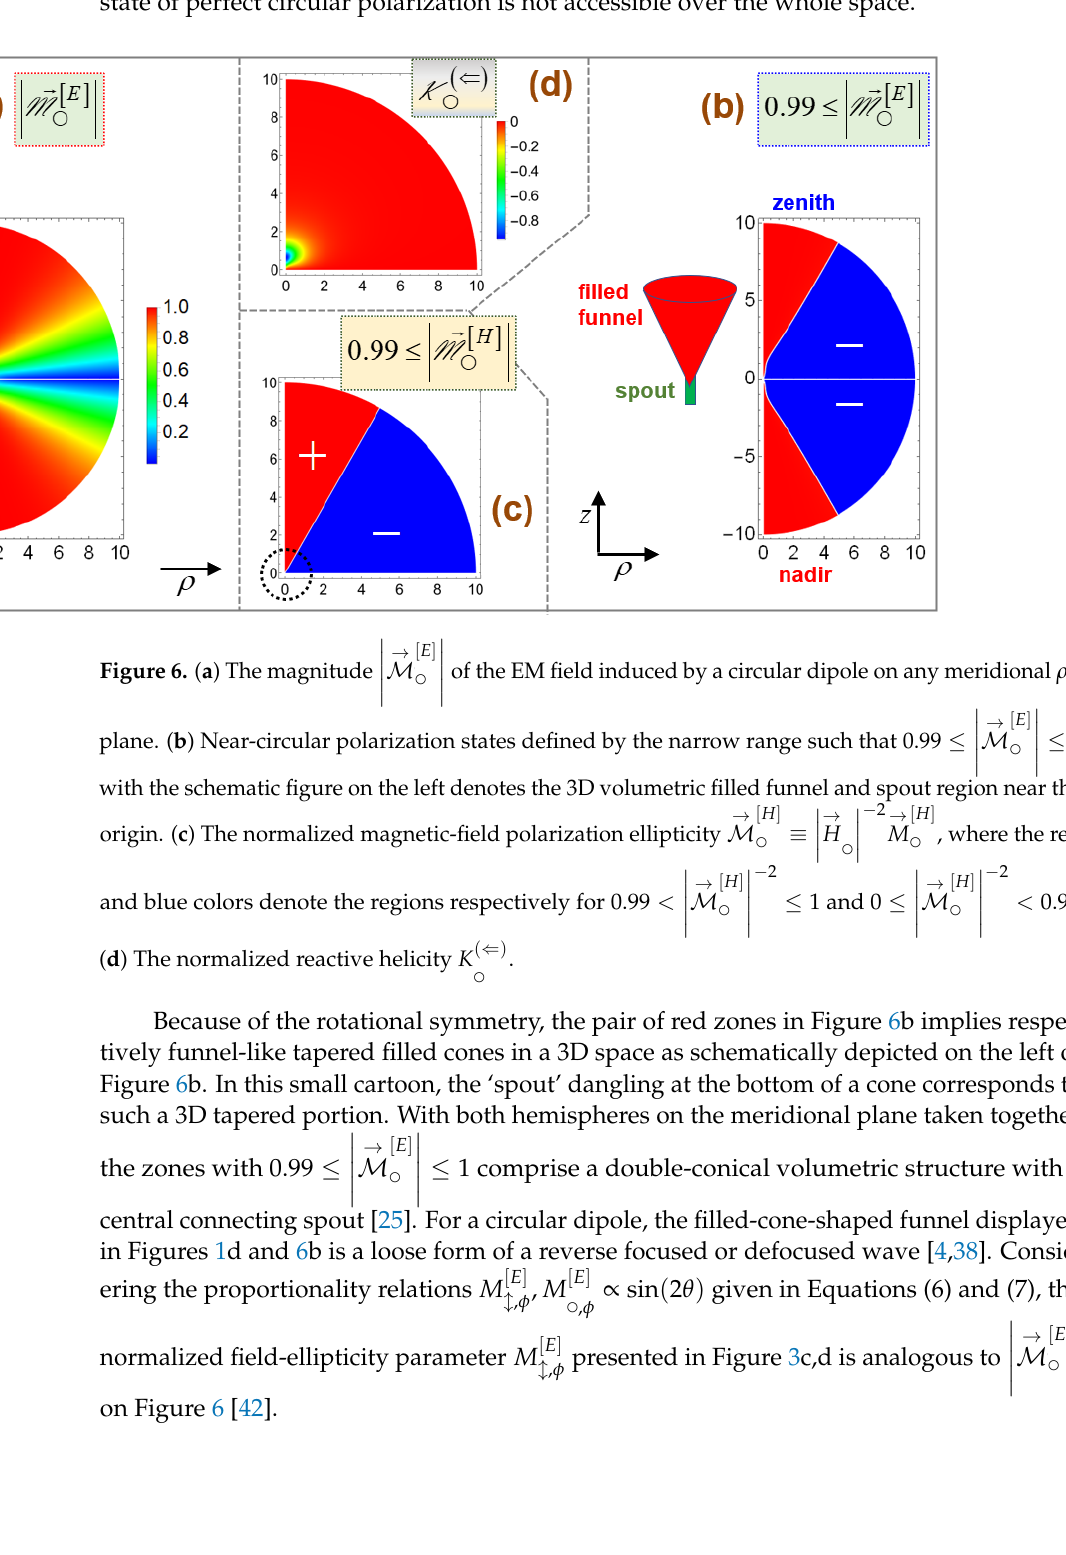
Figure 1. ( a ) Decomposition of a Poynting vector P   energy flux S . Besides, M is a spin angular momentum (SAM) density. ( b ) The coordinate systems. On the origin lies a primary electric point dipole represented by its unit vector ˆ p . ( c ) A linear dipole ˆ p with its dipole axis lying parallel to the vertical axis leads to a pencil-hull-like  tapered cylindrical surface designating higher values for the degree of circular polarization (DoCP). with its dipole axis lying on the horizontal plane leads to a filled solid ( d ) A circular dipole ˆ p  ○ cone of higher values of DoCP. 